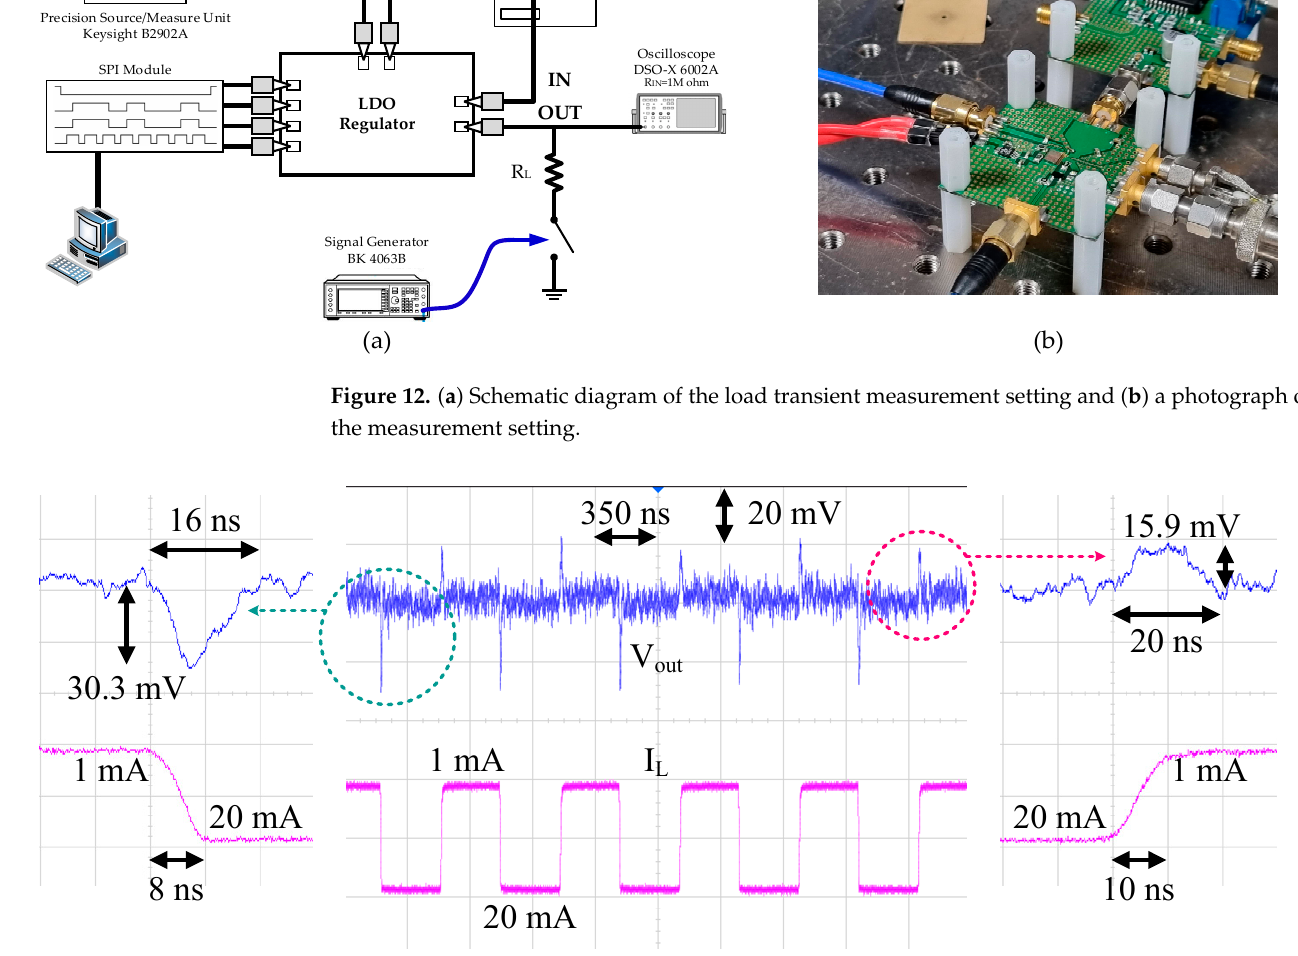
Figure 13. Load transient measurement result. The line transient measurement setting was the same as the PSRR measurement setting, and the only difference was that the ripple signal, f R , was replaced with a square wave. The line transient measurement result is given in Figure 14. With the power supply voltage changing from 1.2 V to 1.4 V within 20 ns, the output voltage changed by about 25.7 mV. The settling time to the final value was about 40 ns.